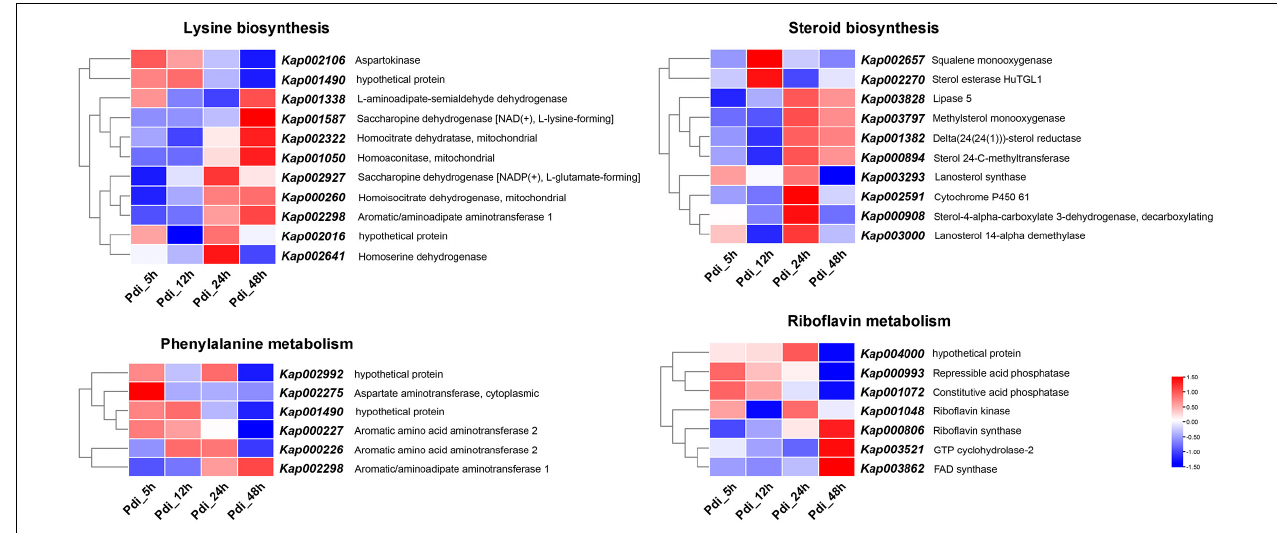
FIGURE 6 | The expression of lysine biosynthesis, phenylalanine metabolism, riboflavin metabolism, and steroid biosynthesis of K. apiculata co-incubation with P. digitatum